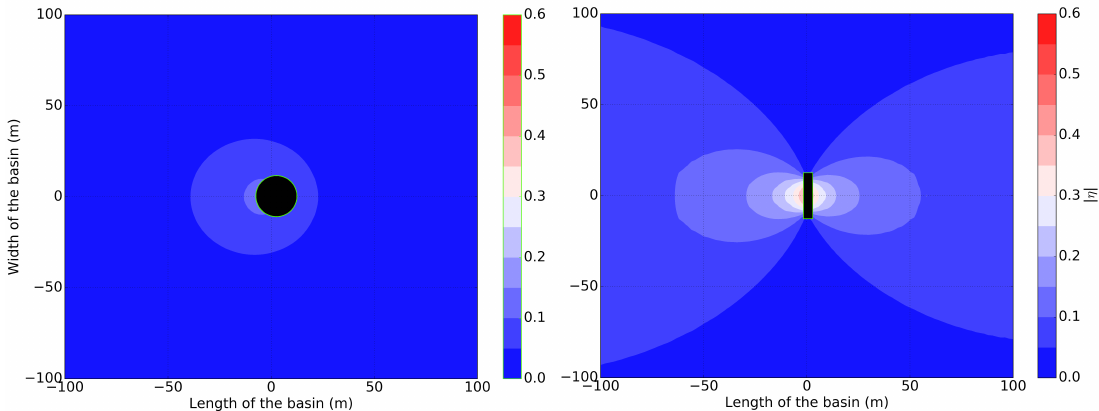
Figure 8. Modulus of the diffracted surface elevation | η | for a heaving cylindrical WEC ( left ) and an OSWEC ( left ). Incident wave of H = 1.0 m, T = 10.0 s propagating from the